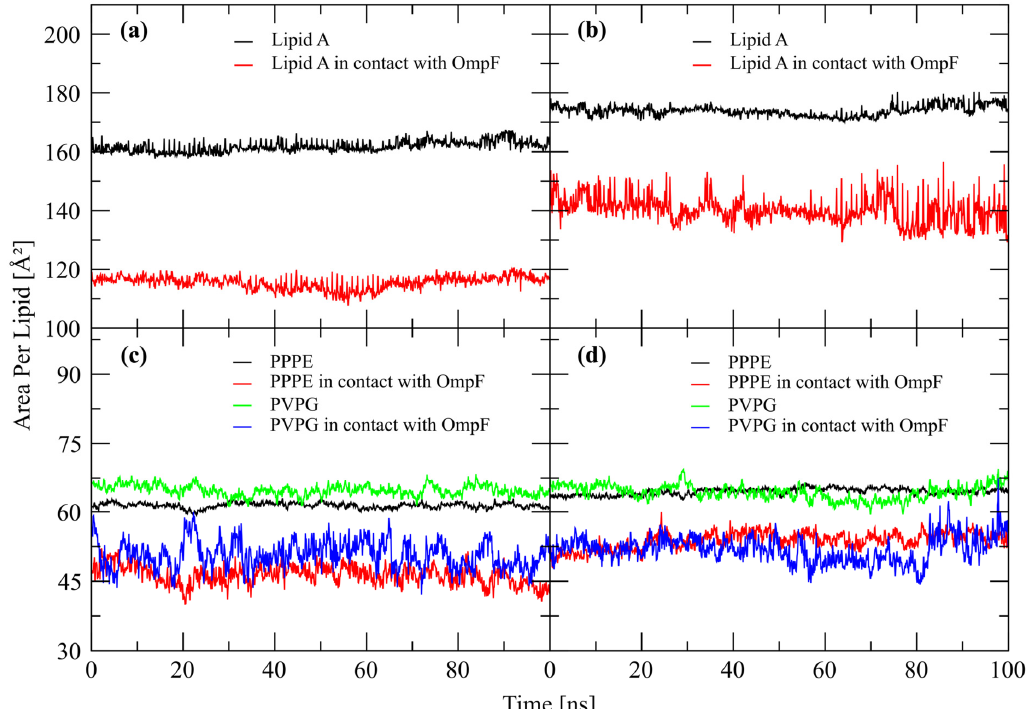
Figure 4. Lateral packing of LPS (lipid A) and PL (PPPE and PVPG) molecules by the OmpF monomer during MD simulations: ( a ) lipid A from S-LPS, ( b ) lipid A from R-LPS systems; ( c ) PL from S-LPS and ( d ) PL from R-LPS systems.